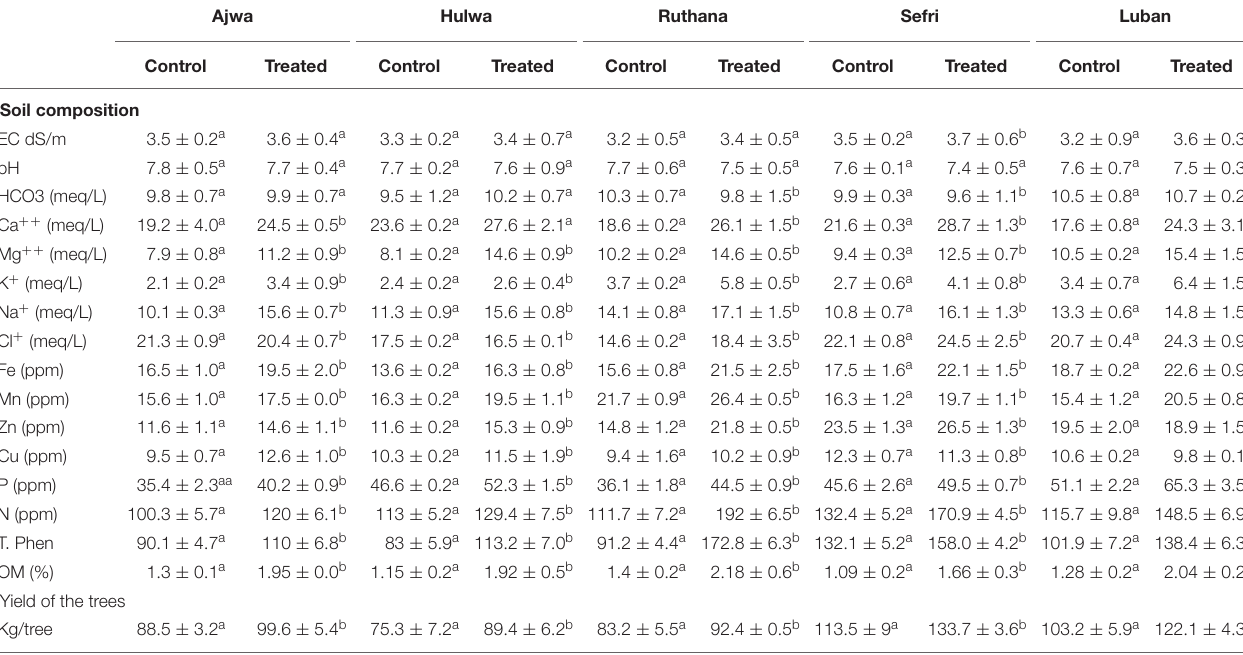
TABLE 1 | Vermicompost fertilization effect on the properties of rhizospheric soil and the yield of five palm cultivars. Ajwa Hulwa Ruthana Sefri Luban Control Treated Control Treated Control Treated Control Treated Control